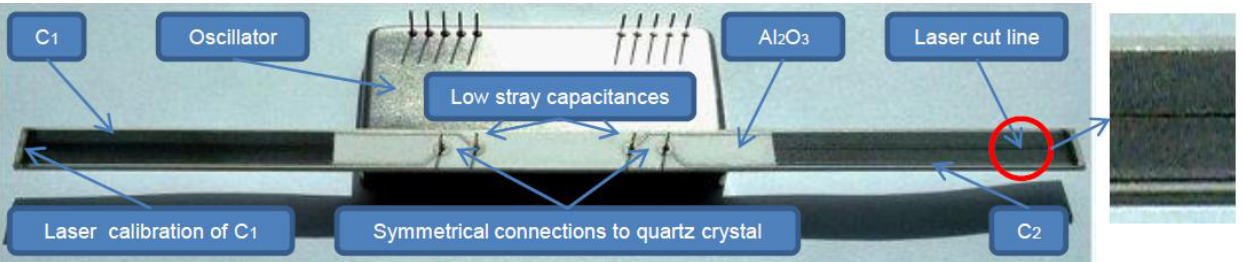
and C produced on Al 1 2